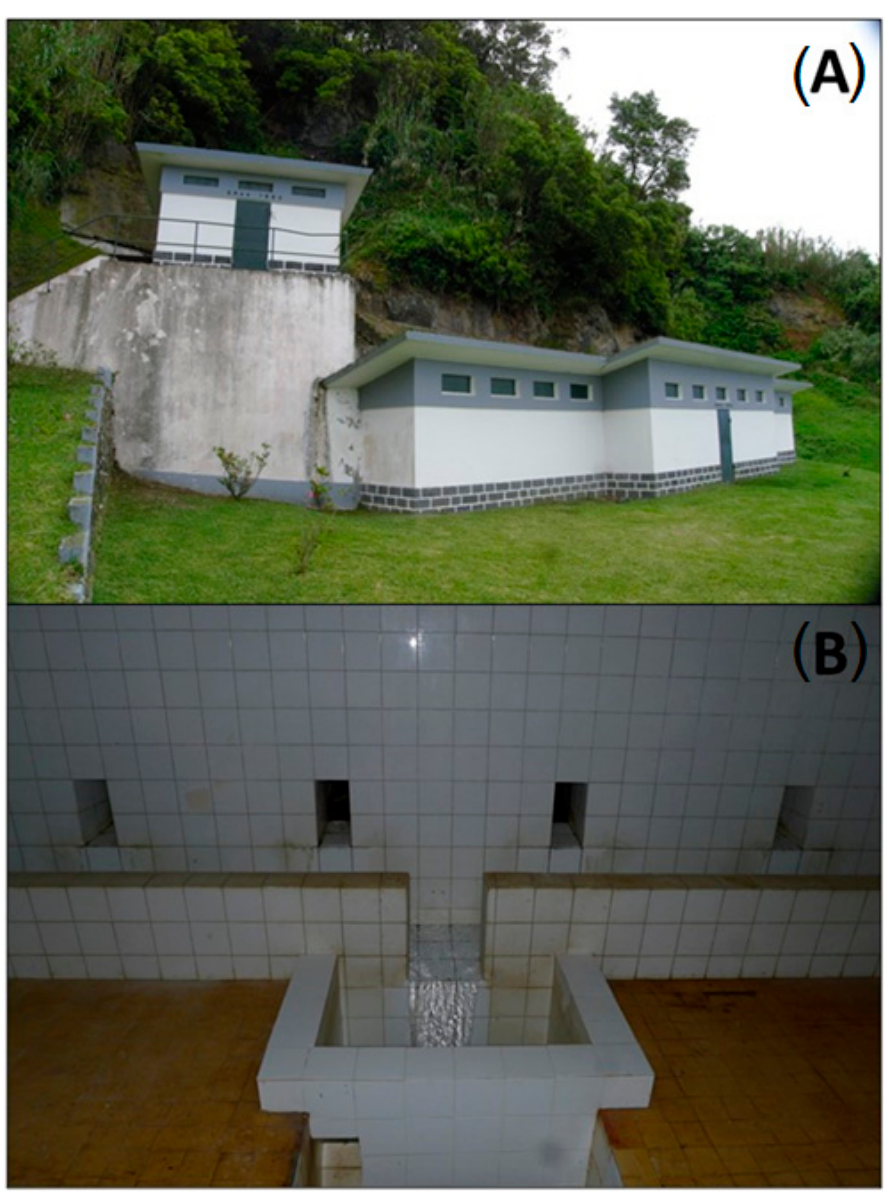
Figure 2. View of the Ch ã dos Tanques spring (Feteiras, Sete Cidades): ( A ) External view; ( B ) interior of the spring